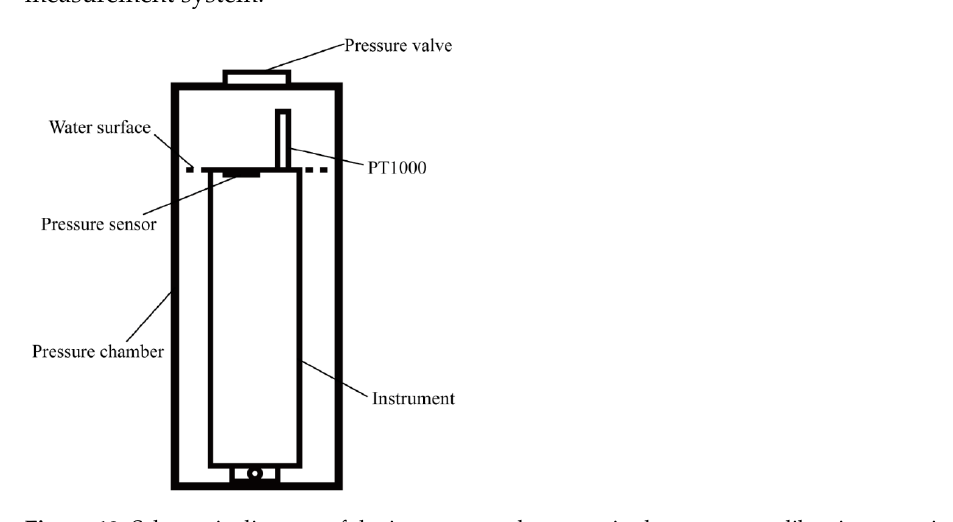
Figure 18. Schematic diagram of the instrument placement in the pressure calibration experiment.